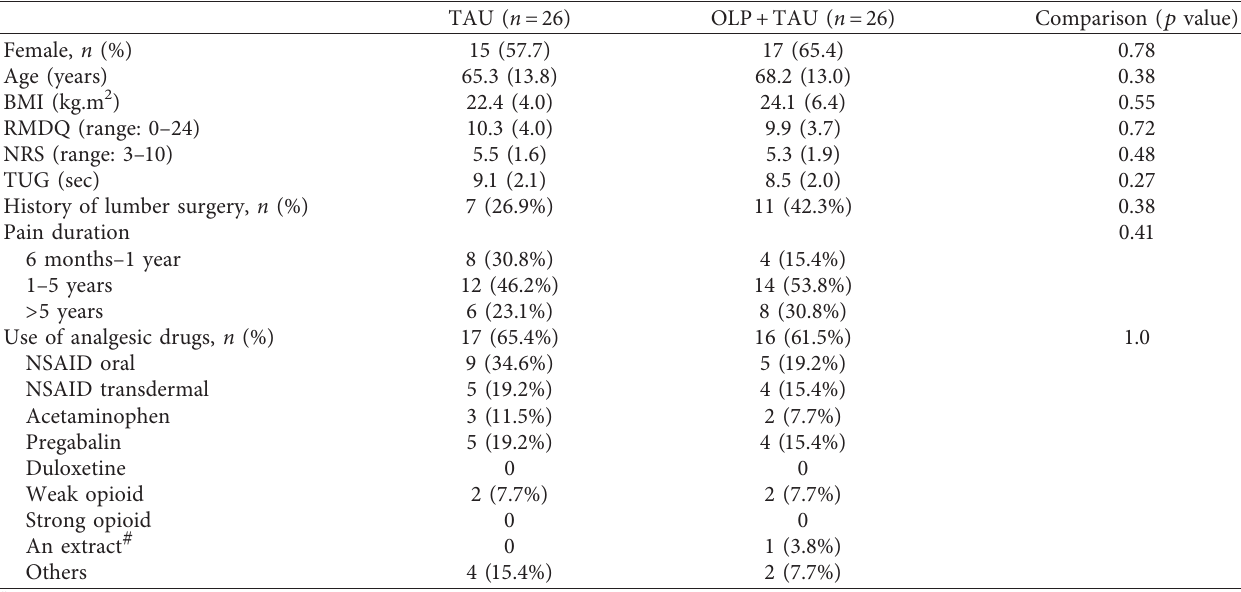
Figure 1: Flow diagram of the randomized trial comparing the TAU group or TAU +OLP group. Table 1: Comparision of parameters at the baseline TAU group and TAU +OLP